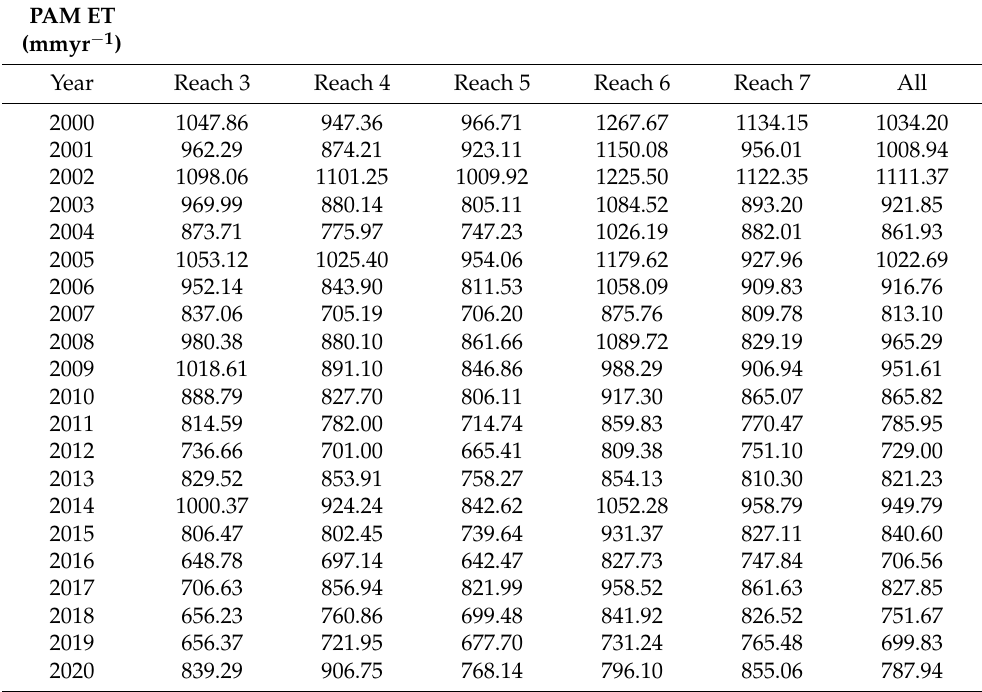
Table 4. PAM ET (mmyr − 1 ), total annualized water use, for each of the 21 years from 2000 to 2020 for five reaches and the weighted average of All reaches along the Lower Colorado River.